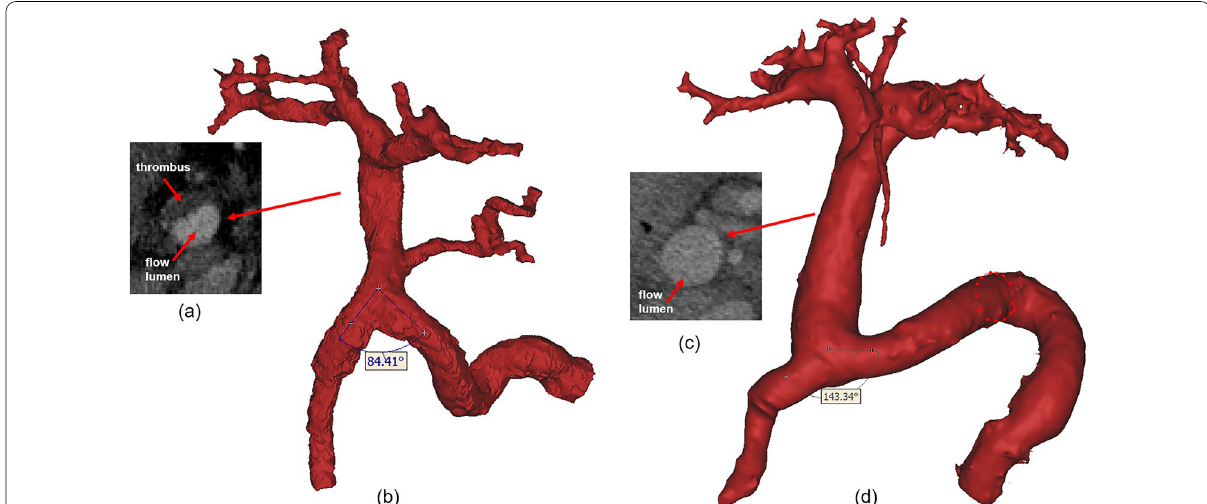
Fig. 2 The represented morphology in patients with PVT ( b ) and without PVT ( d ); a and c show the detail of portal vein cross section in the patient with PVT it without PVT,